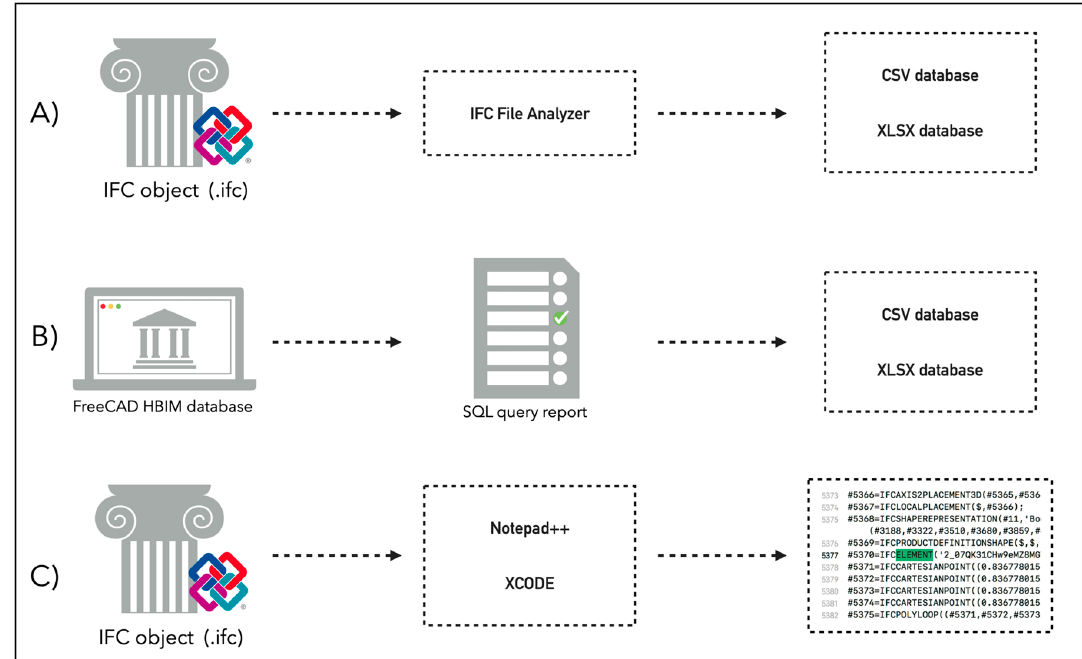
Figure 19. IFC objects external investigations summary: ( A ) IFC File Analyzer method; ( B ) SQL query report exportation; ( C ) IFC objects investigation and validation through code editors.